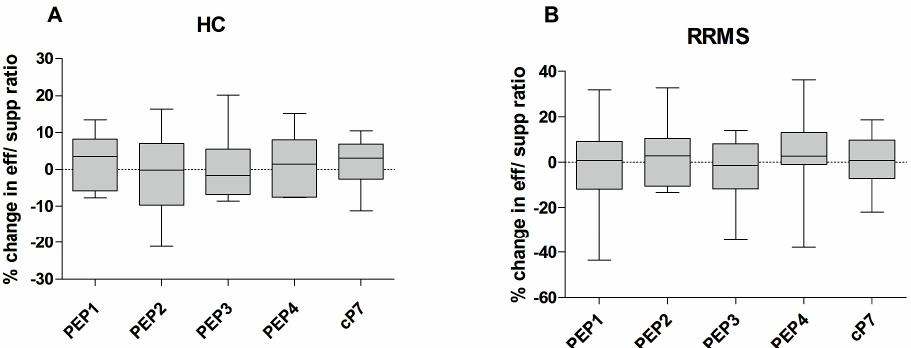
Figure 6. ( A ) Effector/suppressor ratios of HC and patient groups after cultures of PBMC in the absence of antigenic peptides. Note the complementarity with the CD4 + CD25 high Foxp3 + frequencies in Figure 1. * p = 0.05; and ( B ) correlation of effector/suppressor ratios in culture, with the percentage of corresponding CD4 + CD25 high Foxp3 + Tregs (Spearman r = − 0.64, p < 0.0001).